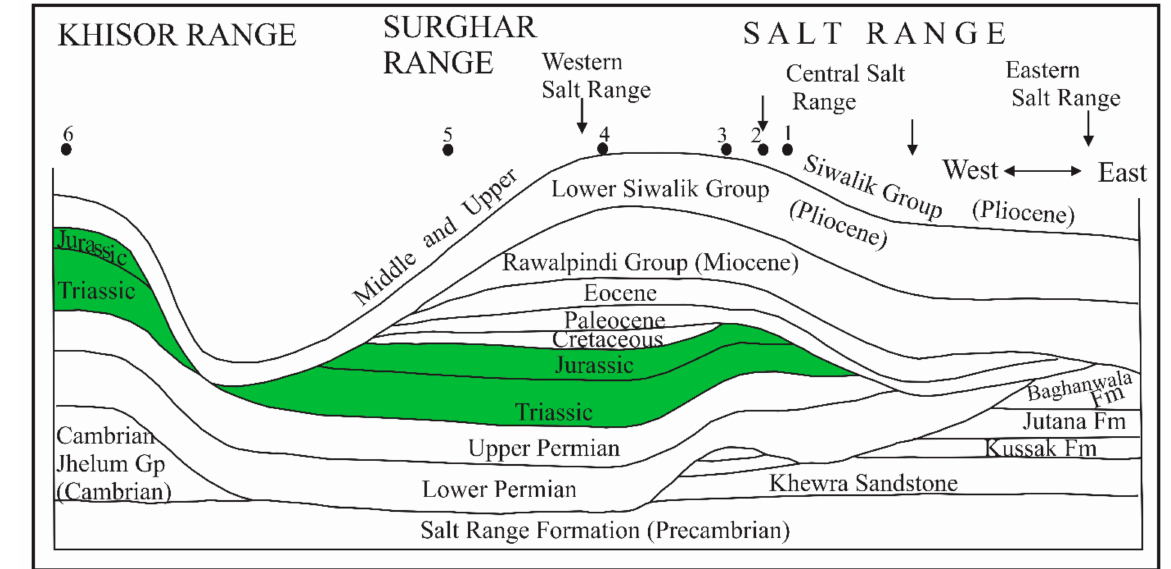
Figure 2. Generalised cross section of the Salt and Trans–Indus ranges showing the distribution of lithostratigraphic units in different parts of the area. Note the angular unconformity between the Cambrian and Permian strata and the absence of Mesozoic strata in the eastern Salt Range. The studied strata are highlighted in green colour. The studied sections are numbered 1–6. 1 = Kasanwala; 2 = Kaowaali; 3 = Nammal Gorge; 4 = Zaluch Nala; 5 = Gulla Khel; and 6 = Paniala. Lower Permian (Tobra, Dandot, Warchha, and Sardhai formations), Upper Permian (Amb, Wargal, and Chiddru formations), Triassic (Mianwali, Tredian, and Kingriali formations), Jurassic (Datta, Shinawari, and Samana Suk formations), Cretaceous (Chichali, Lumshiwal, and Kawagarh formations), Paleocene (Hangu, Lockhart, and Patala formations), Eocene (Nammal, Sakesar, and Chorgali formations), Miocene (Murree and Kamlial formations), and Plio-Pleistocene (Chinji, Nagri, Dhok Pattan, and Soan formations) (modified from